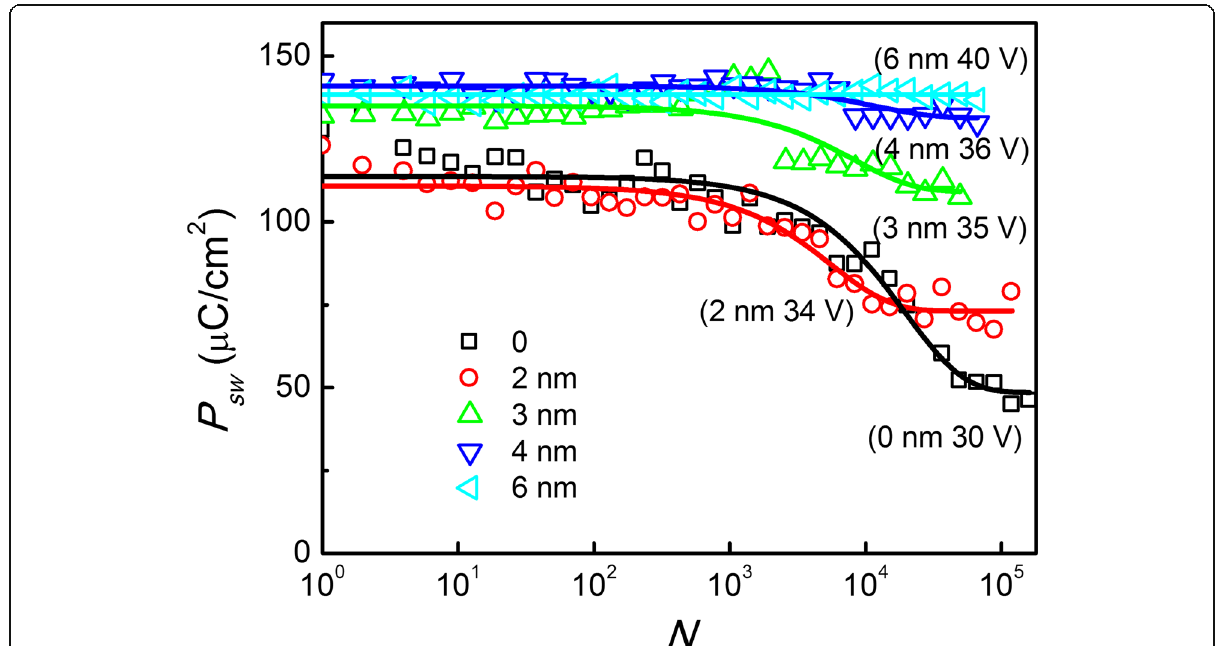
Fig. 6 Cycling number dependences of switched polarizations in Al 2 O 3 /LN bilayer structure with the thickness of Al 2 O 3 ranging from 0 to 6 nm under over 10 4 cycles of pulse stressing. The width of pulses is 1000 ns in the periodicity of 0.5